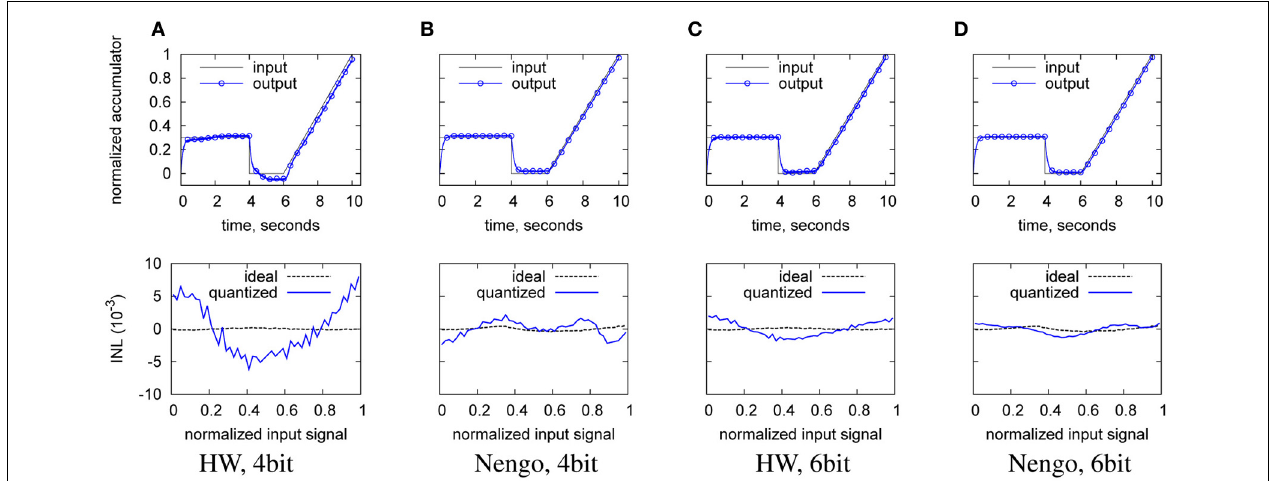
FIGURE 12 | Reproduction of the input waveform in the digitized output (top), and ideal INL (bottom), from left to right. (A) with hardware neurons and 4 bit decoder weight; (B) with Nengo neurons and 4 bit decoder weight;